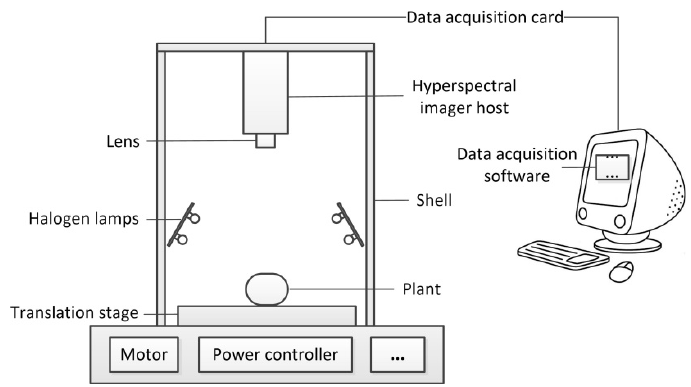
Figure 1. Schematic diagram of the hyperspectral image acquisition system.